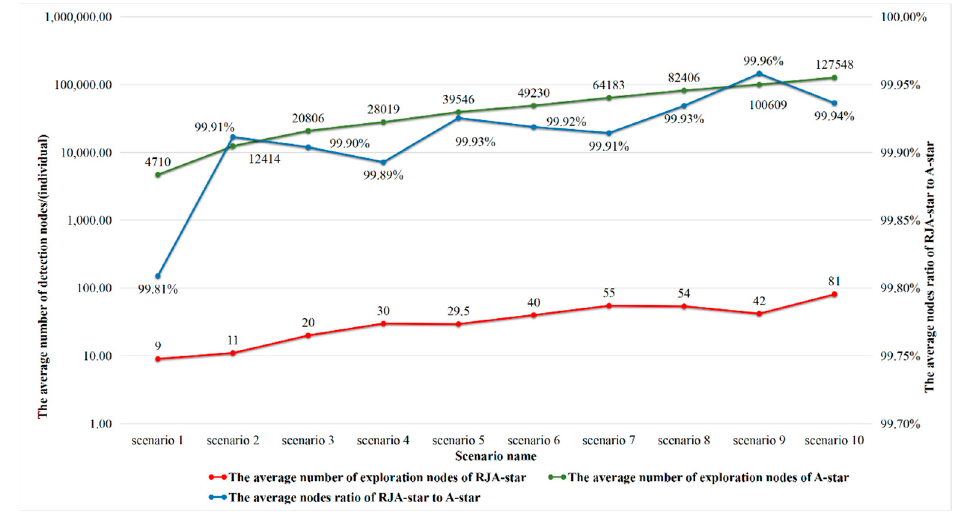
Figure 9. Comparison of two algorithms for exploring nodes.